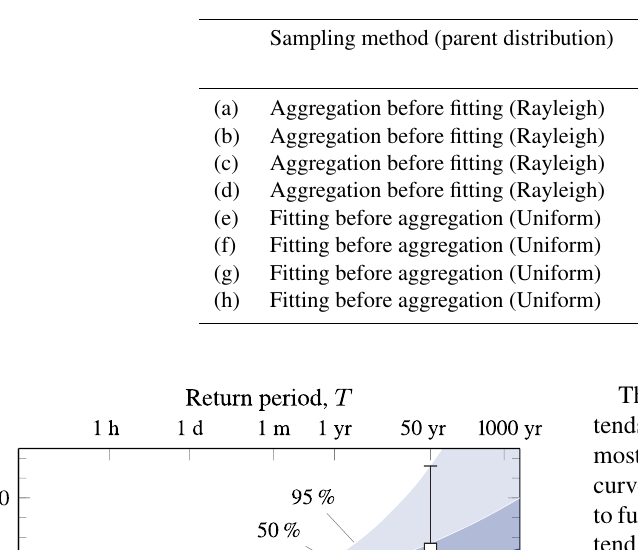
Table 1. Extrapolation cases.